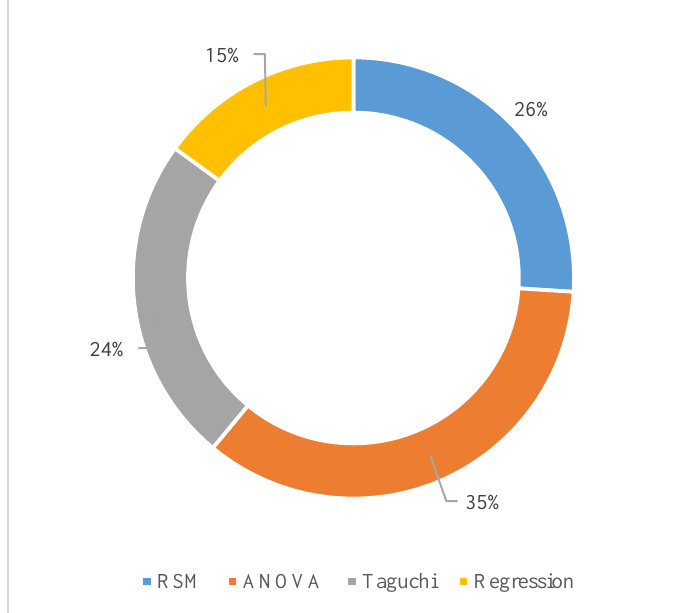
Figure 5. The mathematical methods used to optimize the aluminum alloy cutting processes 2005–2019 period.